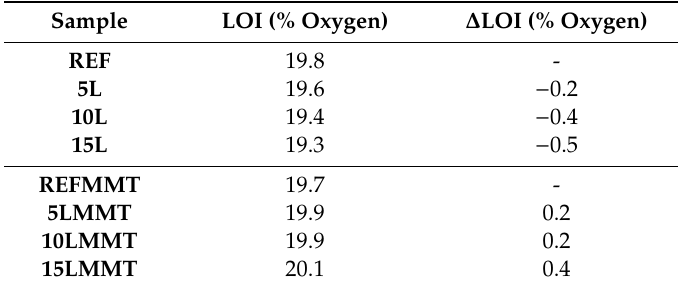
Table 2. Limiting oxygen index (LOI) value summary for the coated polymeric materials using the layer-by-layer (LbL)